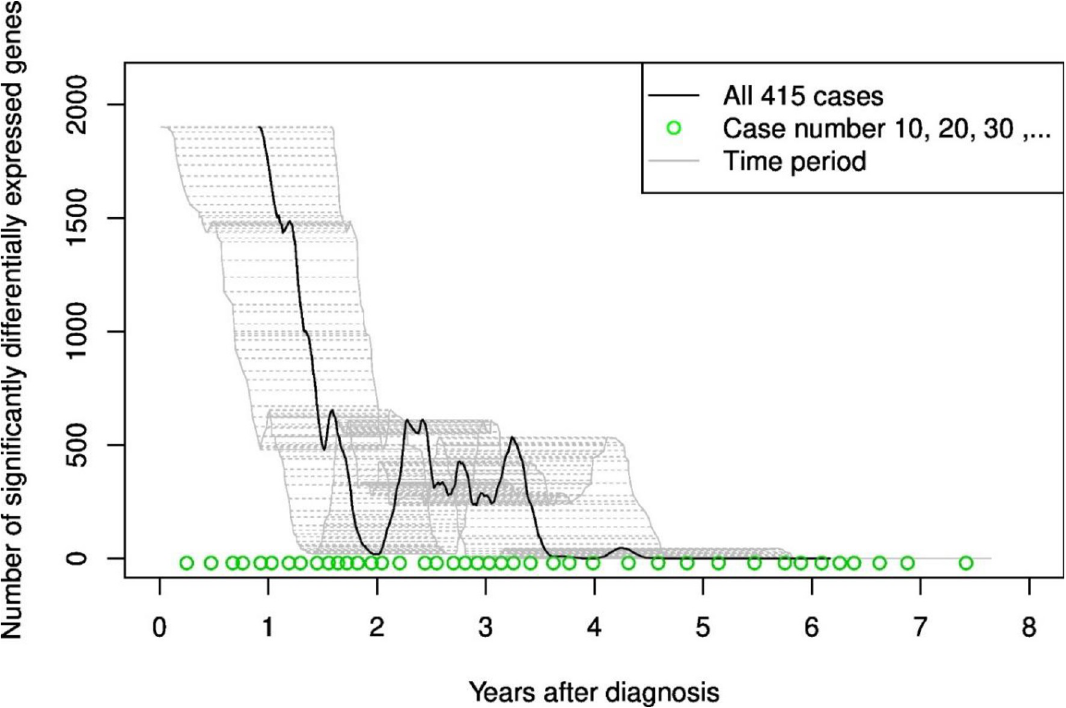
Fig 2. Number of significantly differentially expressed genes for each follow-up time